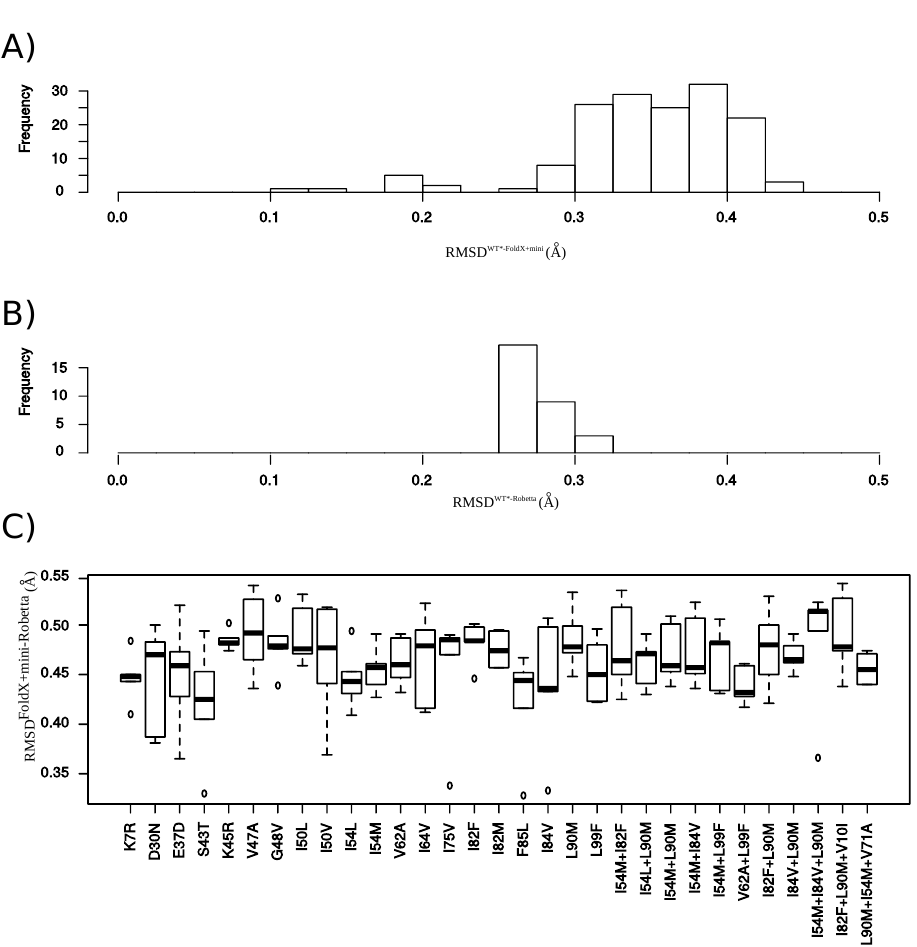
Figure A7. Comparison between mutant FoldX + Mini and mutant Robetta structures. ( A ) RMSD com- puted between the wild-type structure (not minimized, WT ∗ structure) and mutant FoldX + Mini struc- ture. ( B ) RMSD computed between the wild-type structure (not minimized, WT ∗ structure) and mutant Robetta structure. ( C ) RMSD computed between each mutant Robetta structure and the five structure of mutant FoldX + Mini